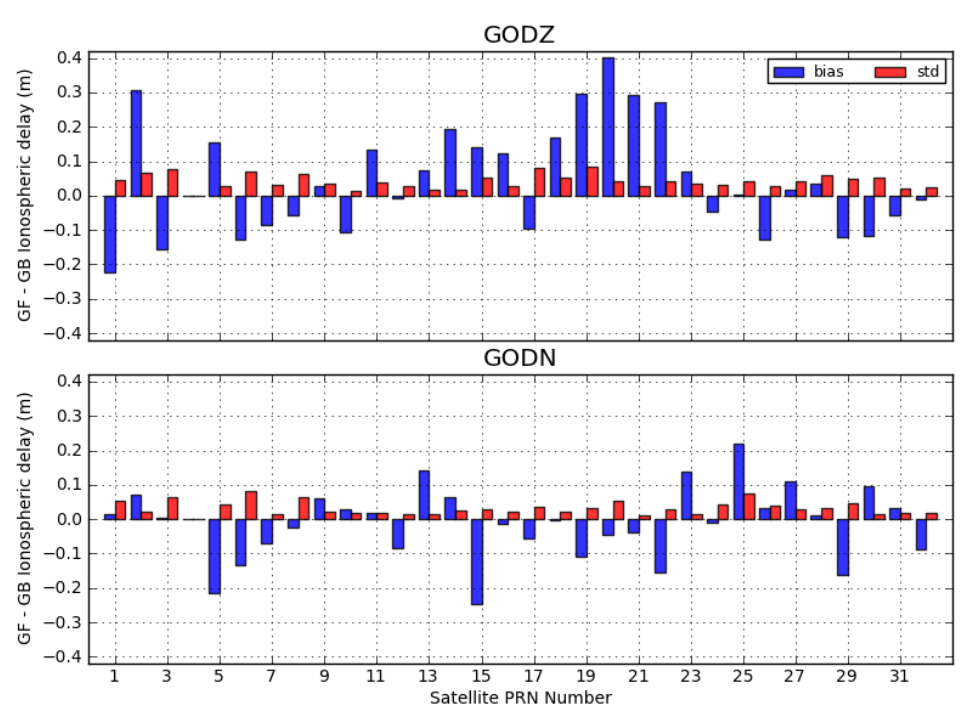
Figure 5. Biases and standard deviations of the GF–GB ionospheric delays for all of the observed satellites computed for the GODZ (top) and GODN (bottom) observations and ESA final OC products.